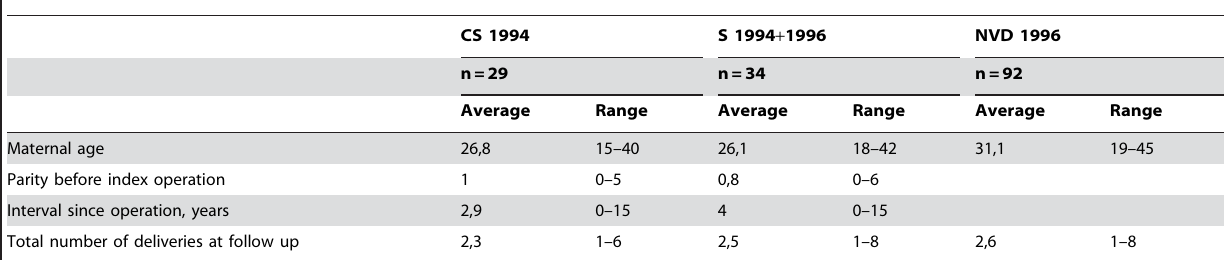
Table 1. Baseline data from the three groups; CS, S, and NVD.